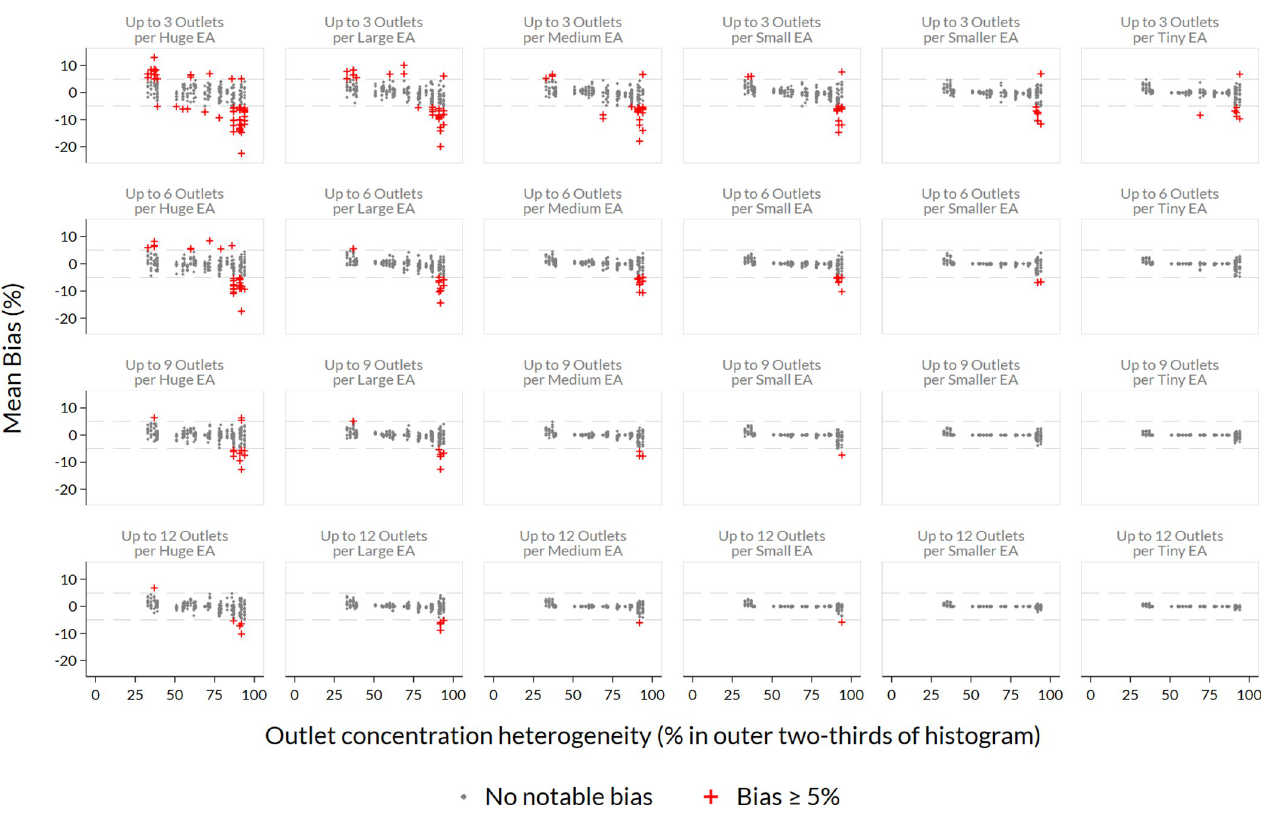
Fig 6. Sampling bias by EA size, sample size, and heterogeneity of outlet density. When outlet concentration is more heterogeneous across the study site, estimates tend to be biased negatively; estimates are more likely to be positive biased when outlet concentration heterogeneity is low. In the CM4FP data, product availability tends to be lower in areas where outlets are less dense, producing this pattern. Notable bias is more often observed when EAs are larger, and the number of outlets sampled per pseudo-EA is smaller. This figure pools data from simulations of all product availability indicators and data from all 12 CM4FP study sites and all rounds of data